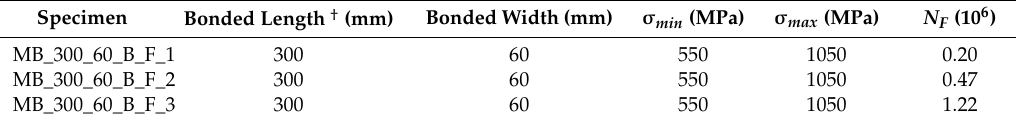
Table 4. Results of fatigue modified beam